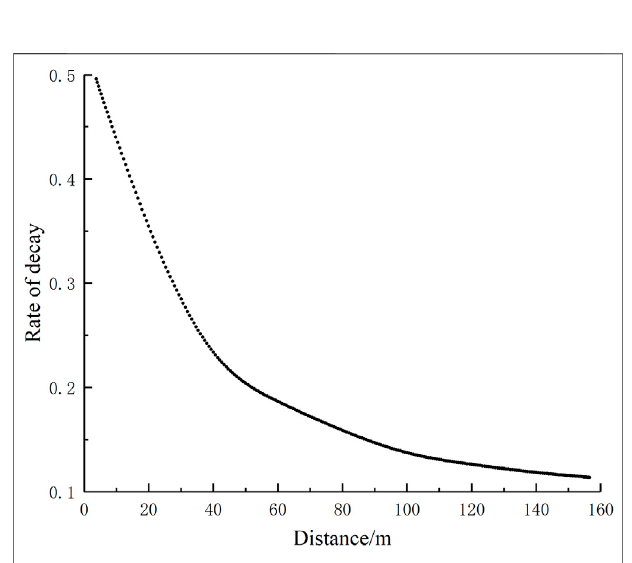
FIGURE 10 | Variation curve of attenuation rate of overpressure peak at every 20 m in working face.